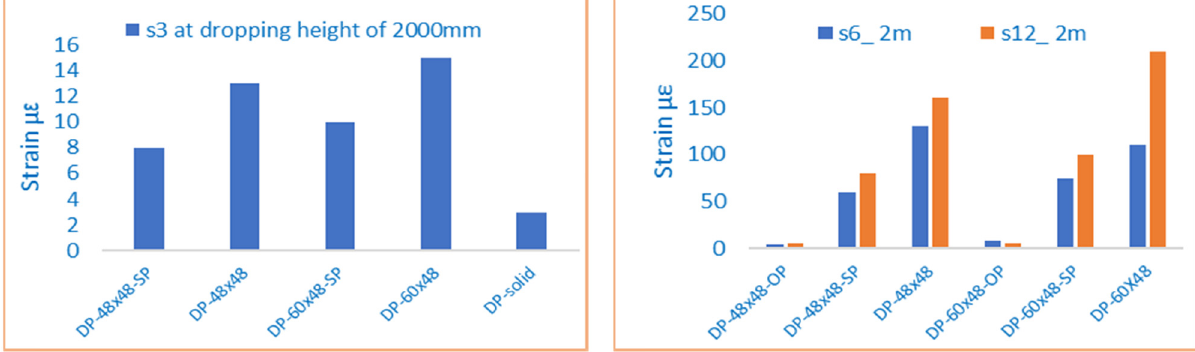
Figure 11: Summary of maximum concrete and steel strains for dropping height of 2,000 mm.